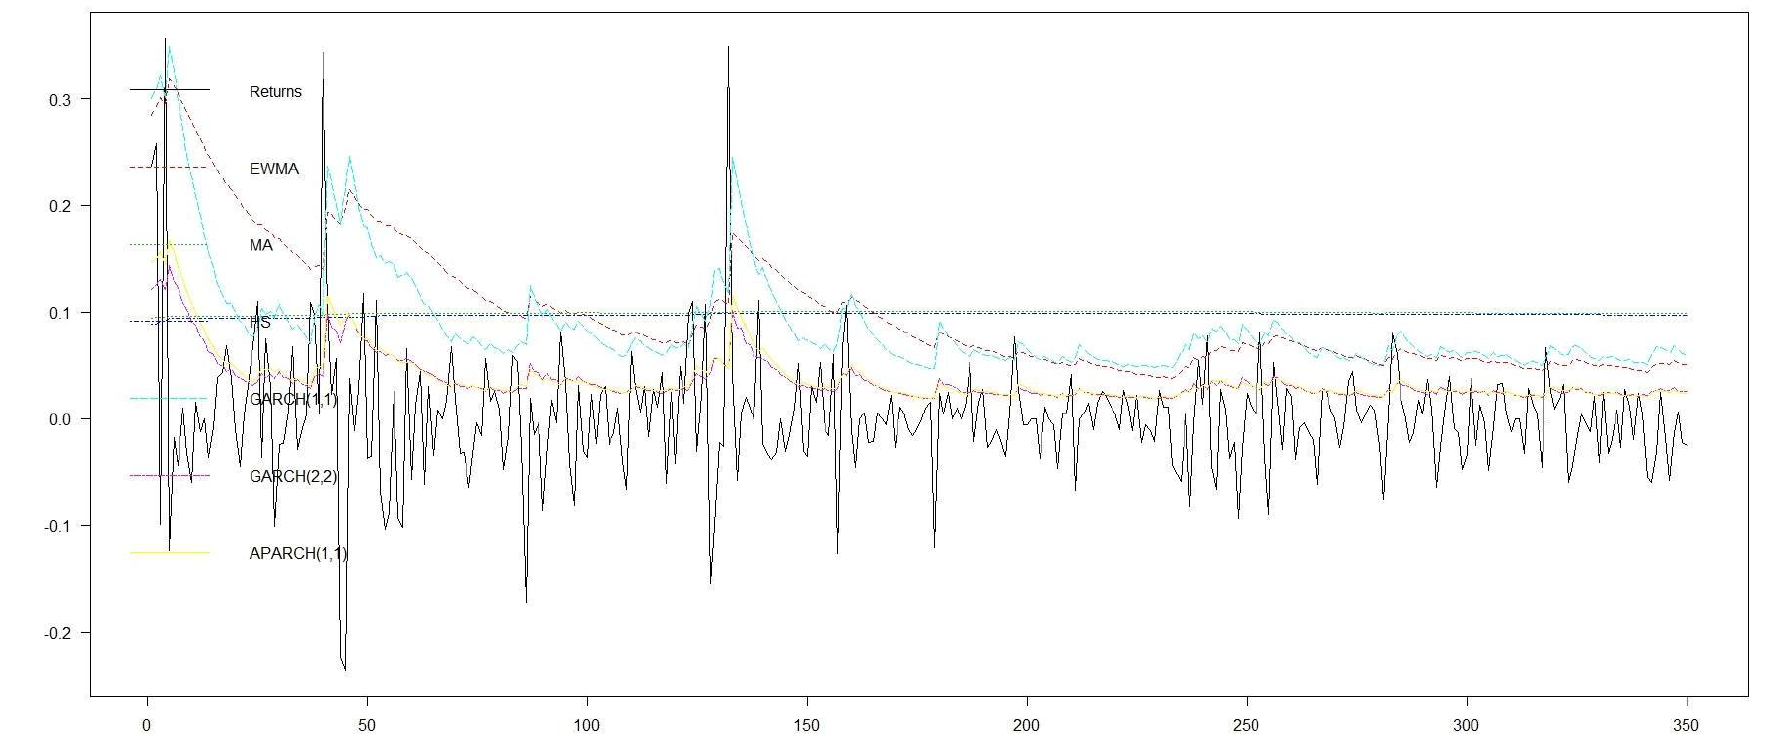
Figure 8. Backtesting without low price